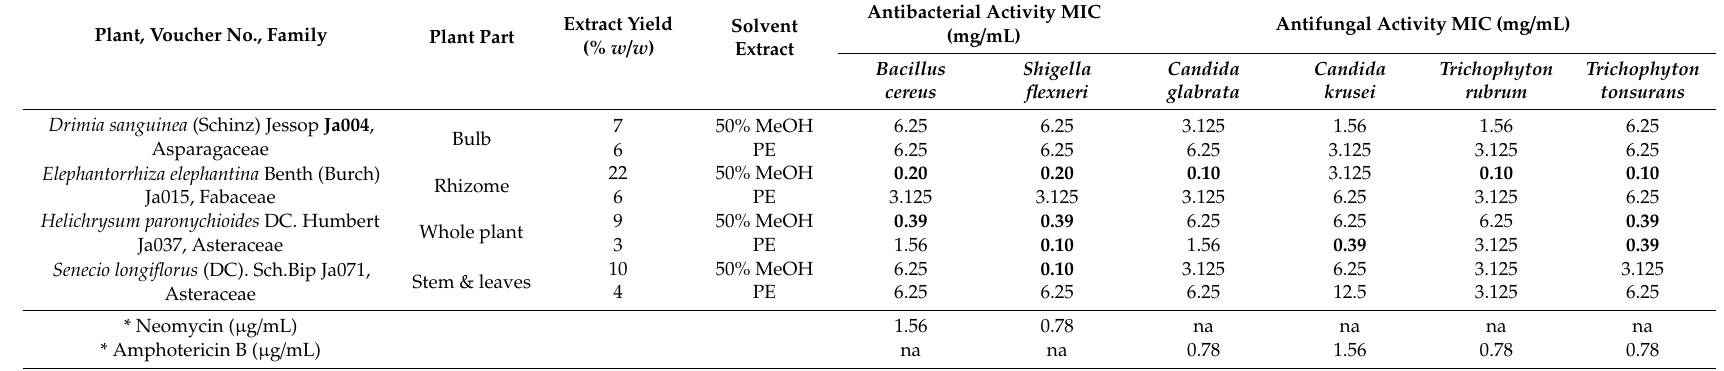
Table 1. Antimicrobial activity (minimum inhibitory concentration, MIC) of four plants used by Batswana traditional health practitioners to treat skin diseases. For the plant extracts, the values in bold are considered as noteworthy (MIC ≤ 1 mg / mL) antimicrobial activity. MeOH = methanol, PE = petroleum ether, * positive control ( µ g / mL) and na = not